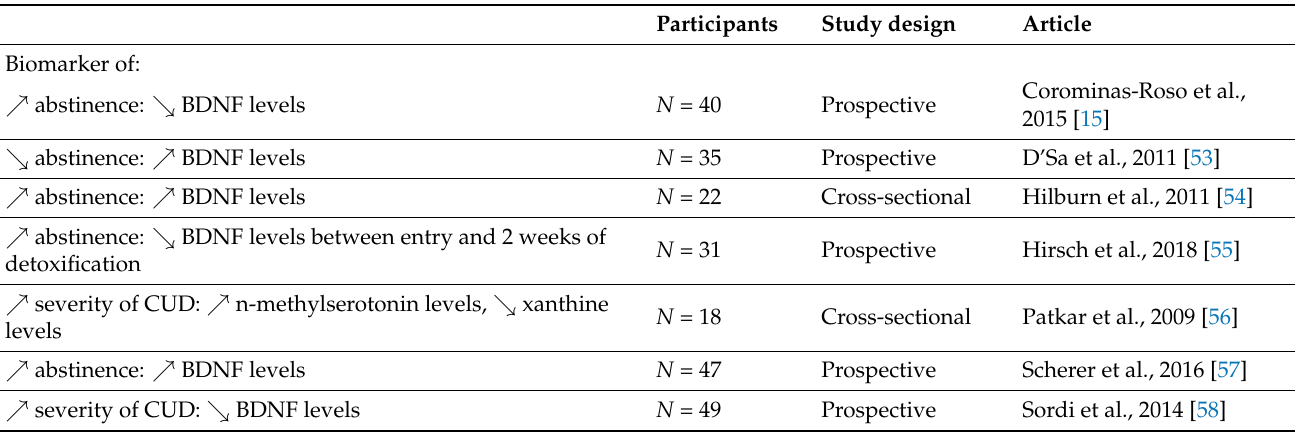
Table 3. Peripheral biomarkers of CNS